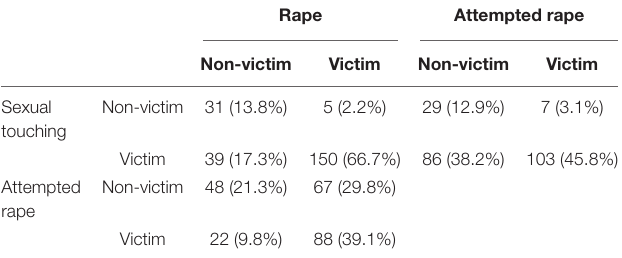
TABLE 4 | Contingency tables for types of assault two by